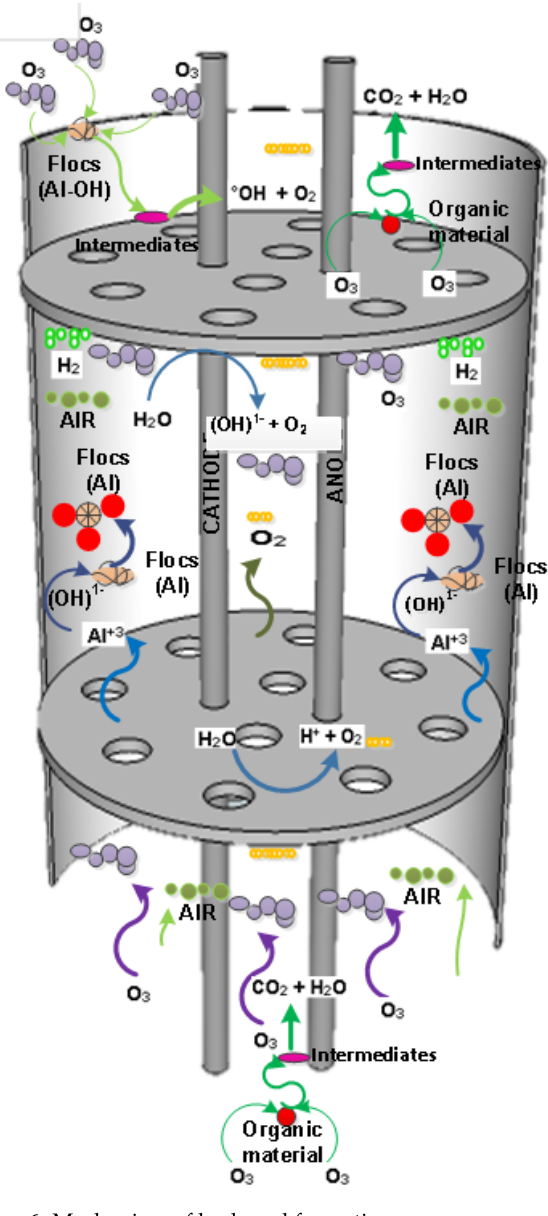
Figure 6. Mechanism of hydroxyl